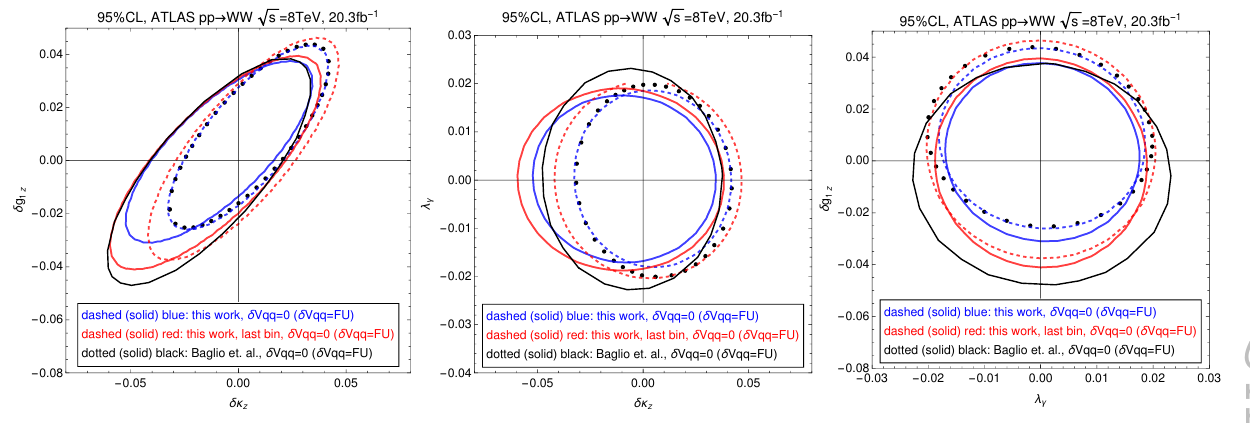
dashed ( solid ) blue:thiswork, δ Vqq = 0 ( δ Vqq = FU ) dashed ( solid ) red:thiswork,lastbin, δ Vqq = 0 ( δ Vqq = FU ) dotted ( solid ) black:Baglioet.al., δ Vqq = 0 ( δ Vqq = FU )